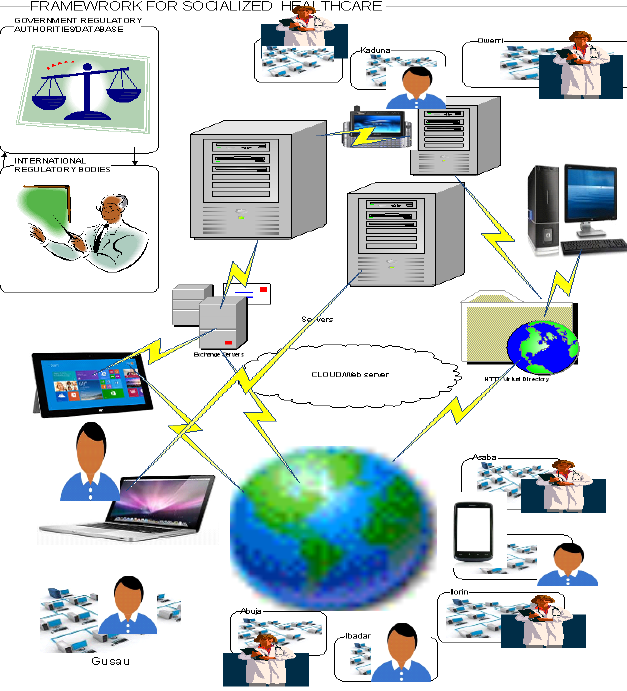
Figure 2. Conceptual